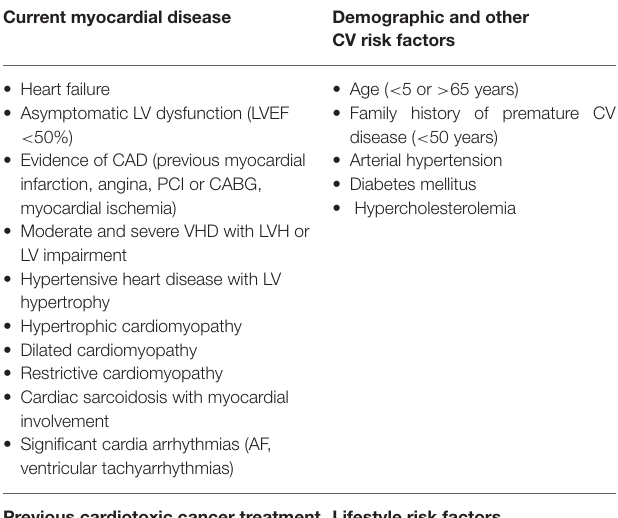
TABLE 1 | Baseline risk factors for anthracycline-induced cardiotoxicity (4, 7). Current myocardial disease Demographic and other CV risk